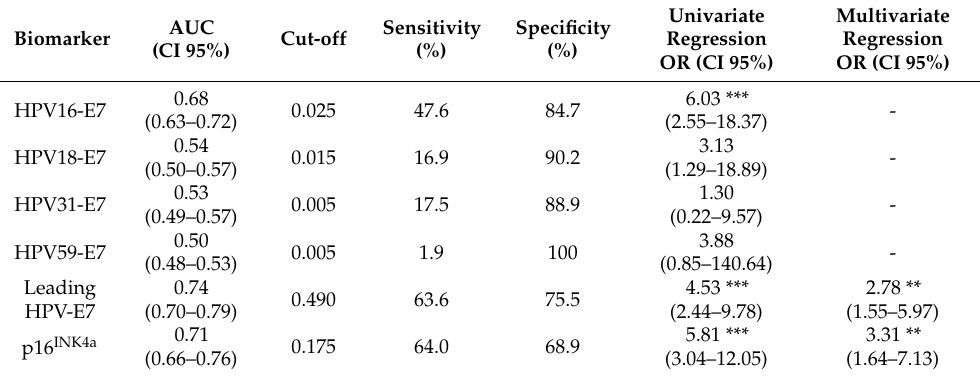
Table 5. ROC analysis and univariate and multivariate logistic regression for high-grade dyspla- sia HCIN+.